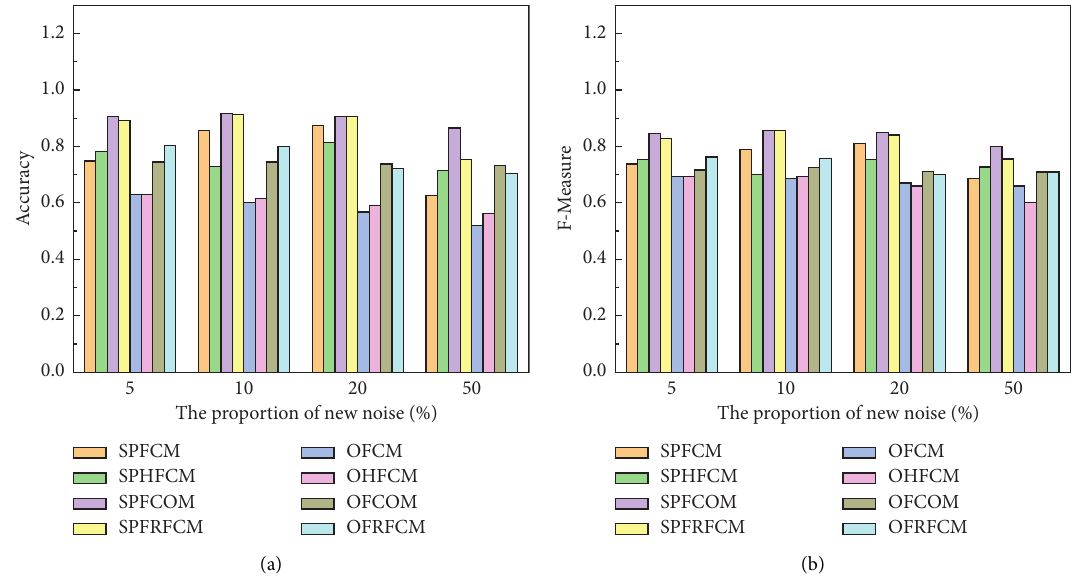
Figure 4: Robustness comparison on the WB dataset. (a) Accuracy; (b)